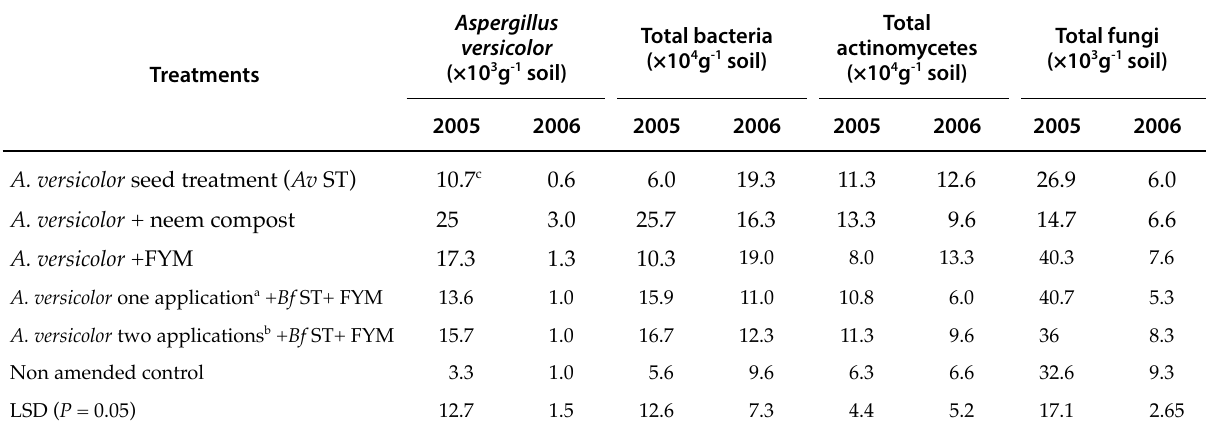
Table 4. Mean soil populations of Aspergillus versicolor and of soil microorganisms in cowpea field plot soils in two growing seasons, after different methods of A. versicolor